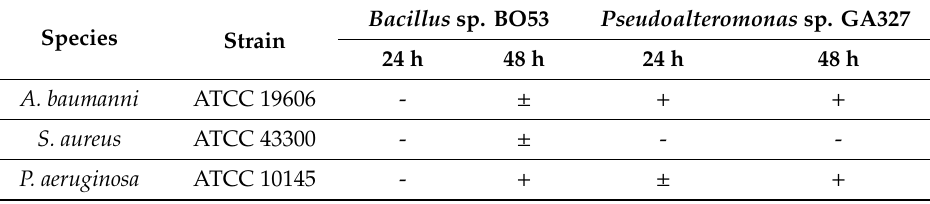
Table 1. Antibacterial e ff ect of Bacillus sp. and Pseudoalteromonas sp. volatile compounds against Acinetobacter baumanni , Staphylococcus aureus , and Pseudomonas aeruginosa pathogenic bacteria.